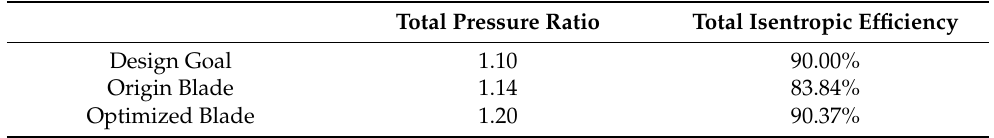
Table 5. Comparison of performances.